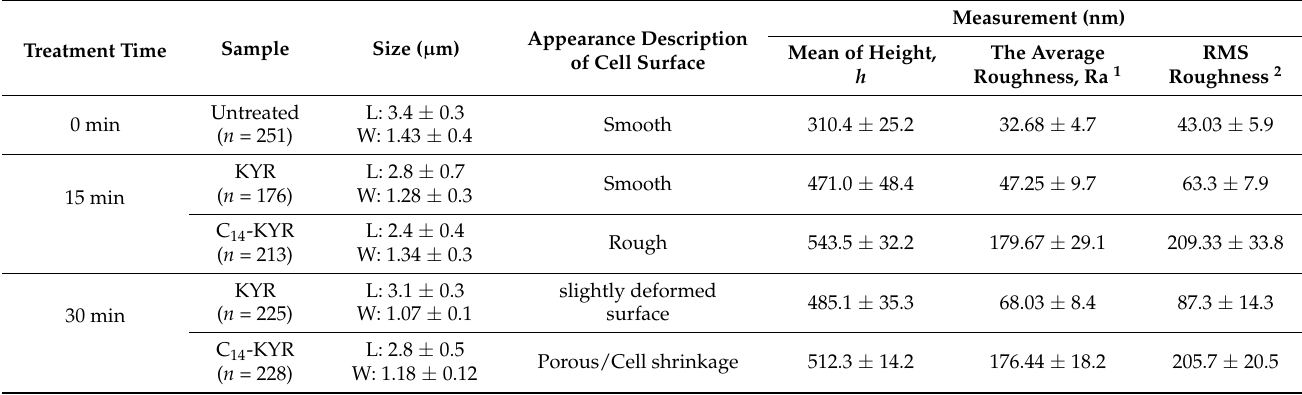
Table 1. Summary of properties of E. coli HB101 cell before and after peptide treatment.